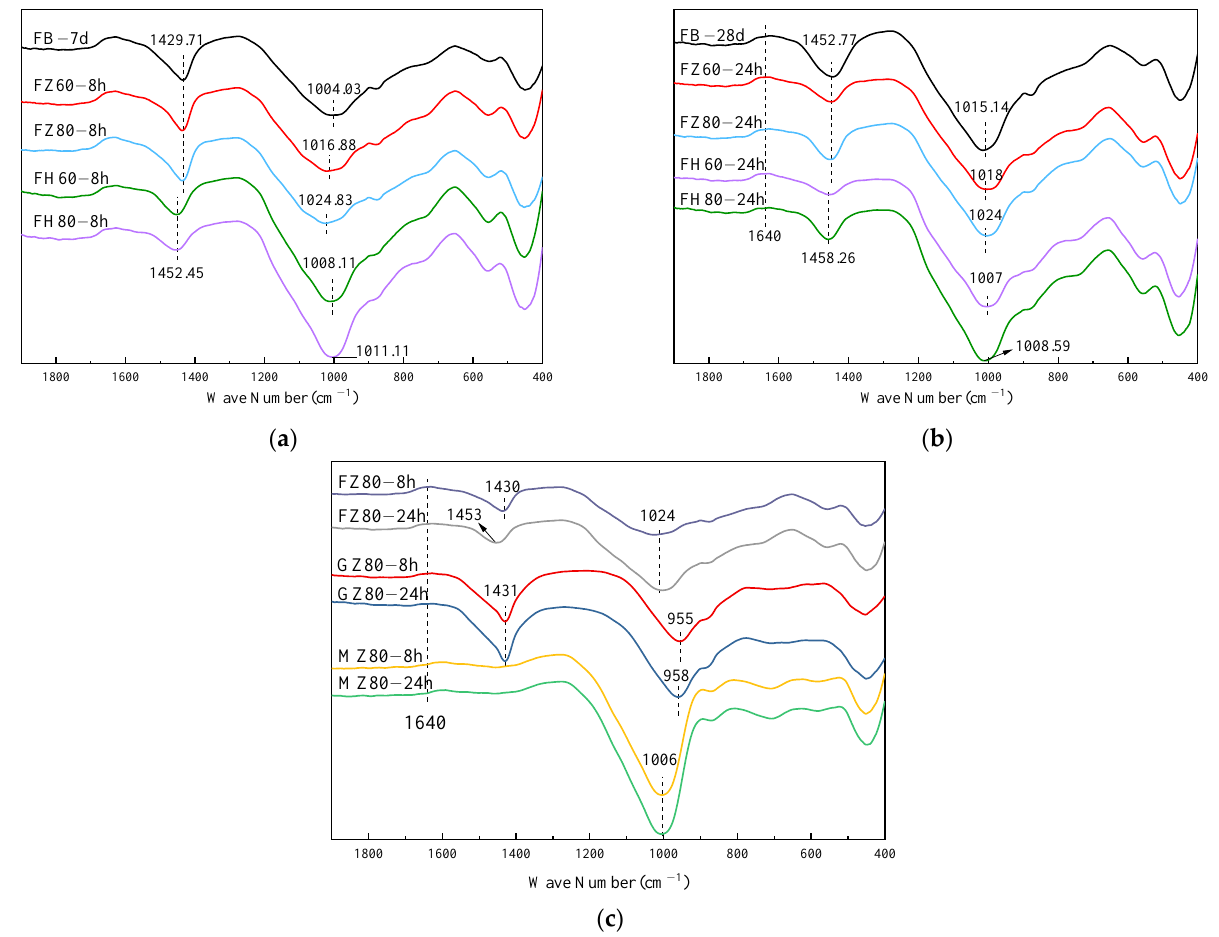
Figure 6. FTIR test results: ( a ) AAF after 7 d/8 h curing; ( b ) AAF after 28 d/24 h curing; ( c ) AAC after 80 °C steam curing.